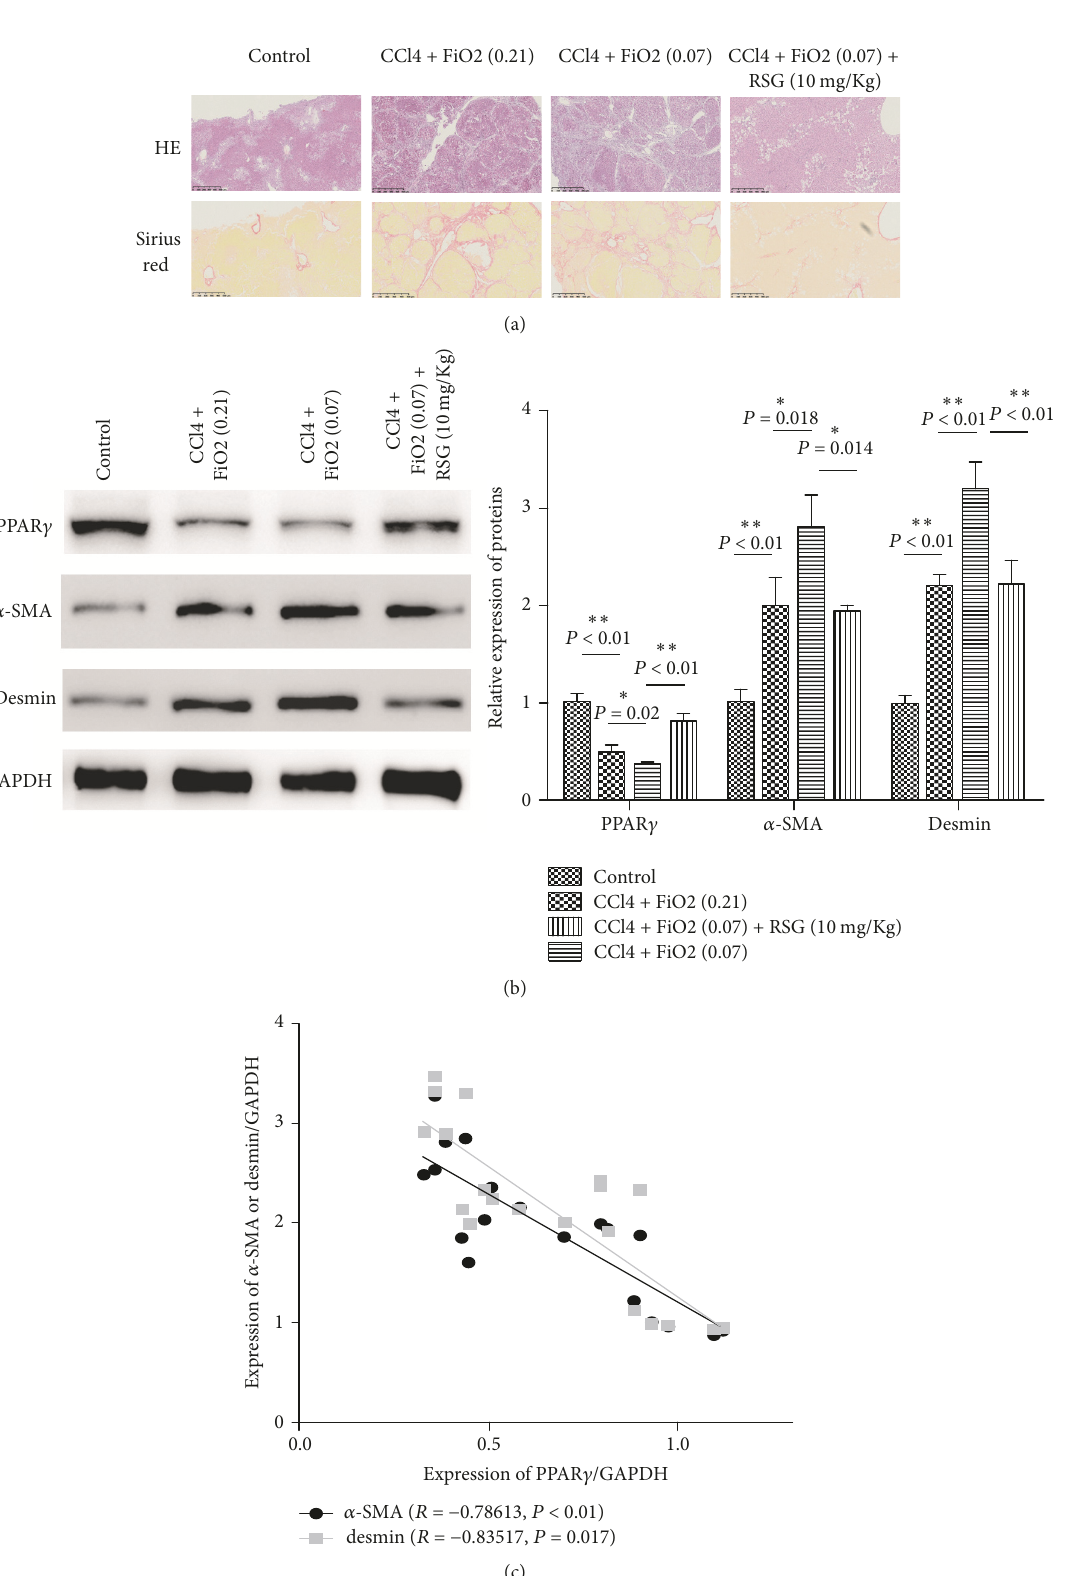
Figure 1: Effects of PPAR 𝛾 on hypoxia-induced hepatic fibrosis. (a) HE and Sirius red staining for liver tissues (magnification, × 200). (b) PPAR 𝛾 , 𝛼 -SMA, and desmin expression of liver tissues in experimental groups were detected by western blotting analysis. (c) The correlation between the expression levels of PPAR 𝛾 and 𝛼 -SMA or desmin. Bars stand for mean ± SD (same for all figures). For each assay, 𝑛 = 3 . ∗ 𝑃 < 0.05 , ∗∗ 𝑃 < 0.01